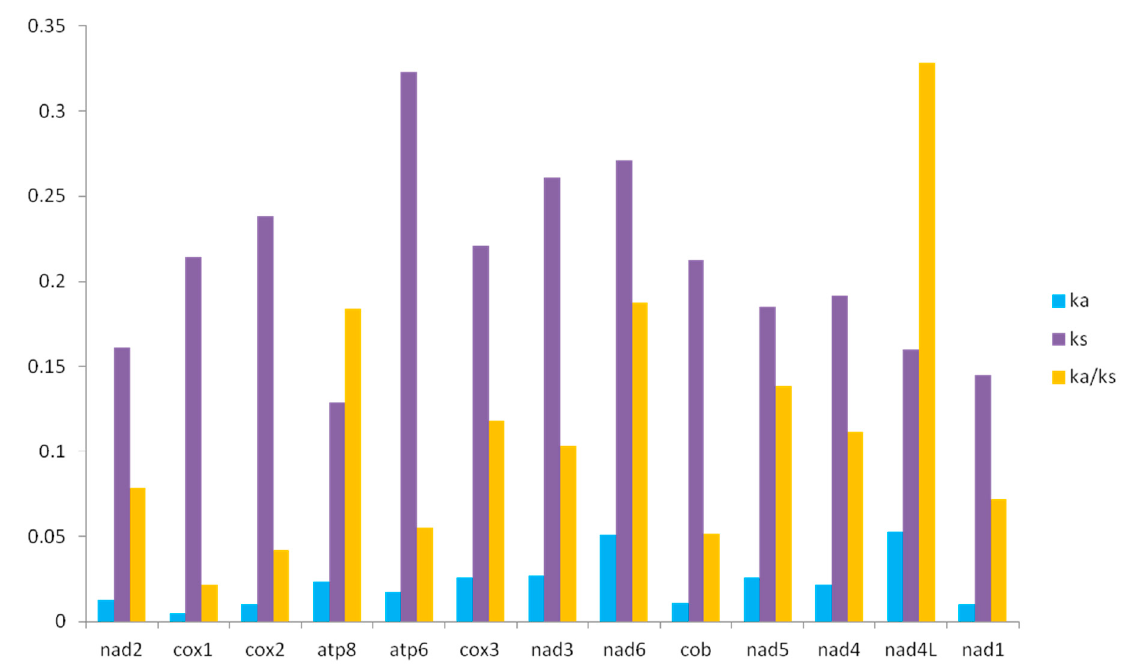
Figure 4. Synonymous (Ka) and non-synonymous (Ks) substitutional rates and the ratios of Ka/Ks of PCGs in 13 grasshoppers of Filchnerella .